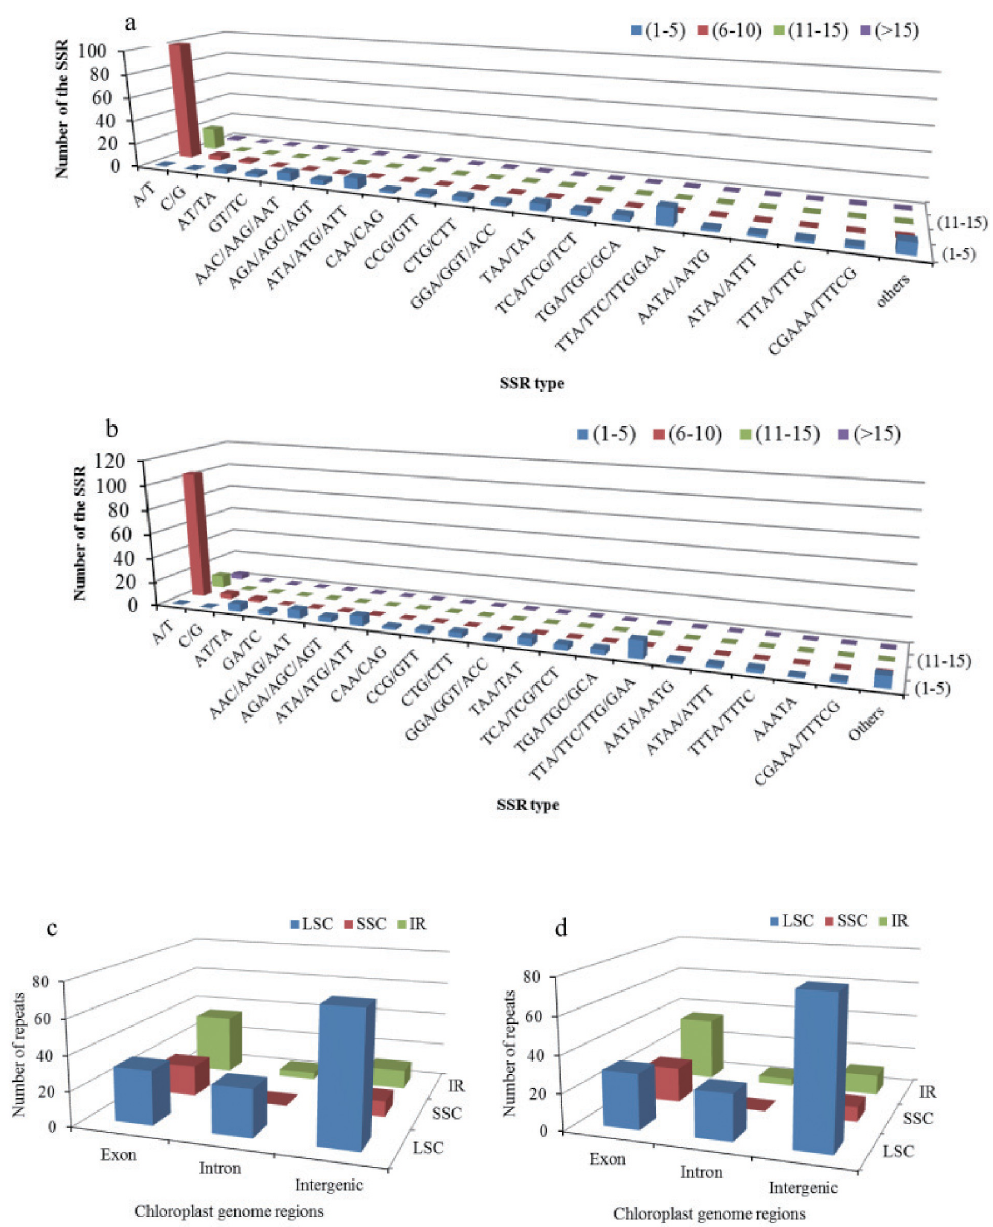
Fig 2. Simple sequence repeats (SSRs) in chloroplast genomes of three Hippeastrum taxa. (a–b) SSR types and distributions in H . alberti (a), H . ‘Milady’ (a), and H . reticulatum (b). (c–d) Distribution of SSRs according to genomic region in H . alberti (c), H . ‘Milady’ (c), and H . reticulatum (d). LSC, SSC, and IR are large single copy, small single copy, and inverted repeat regions, respectively.